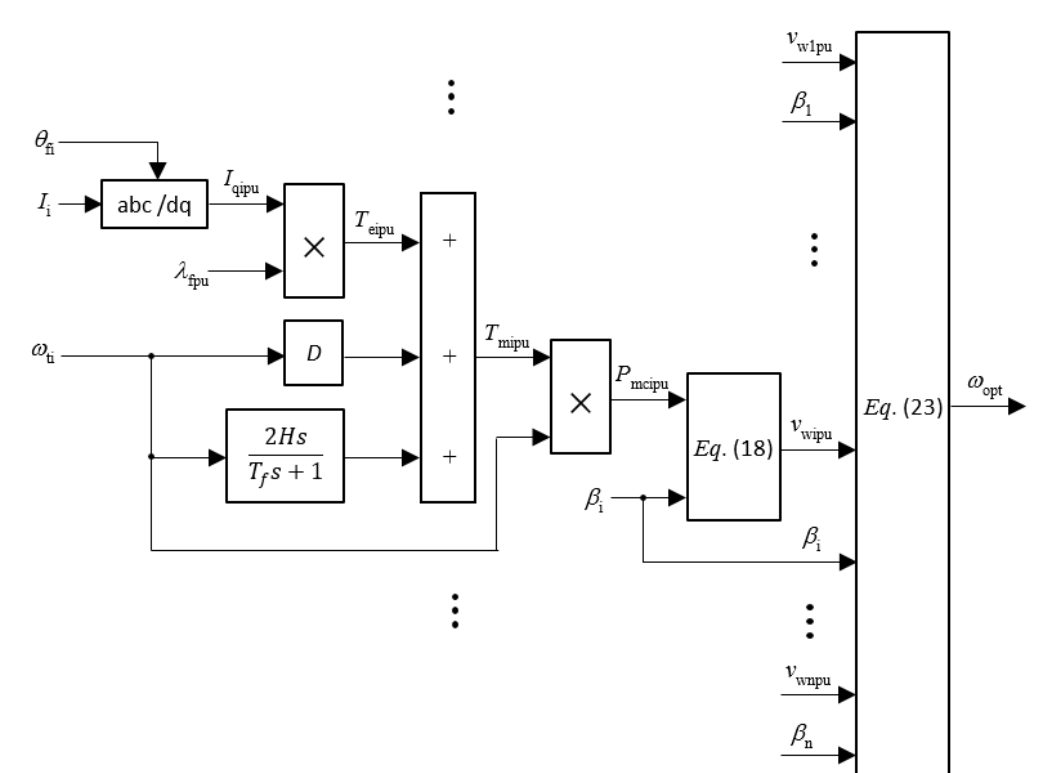
Figure 7. Schematic diagram of the Calculator block.